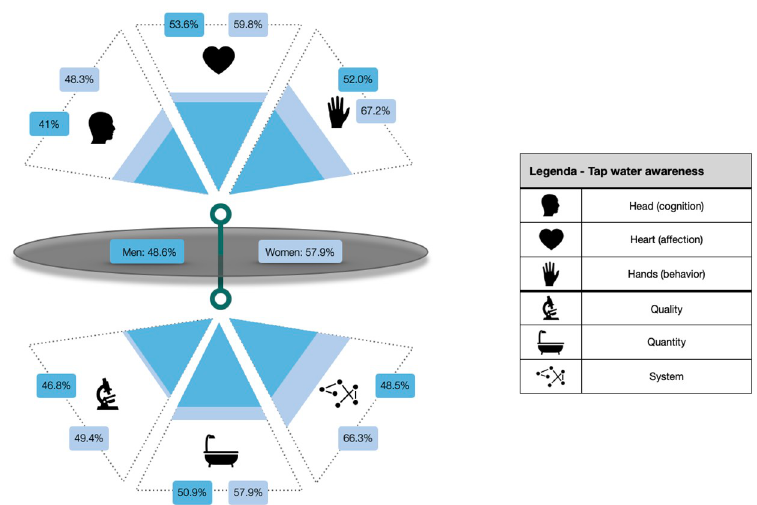
Fig 1. Illustration of the aggregated tap water awareness profile for both women and men.